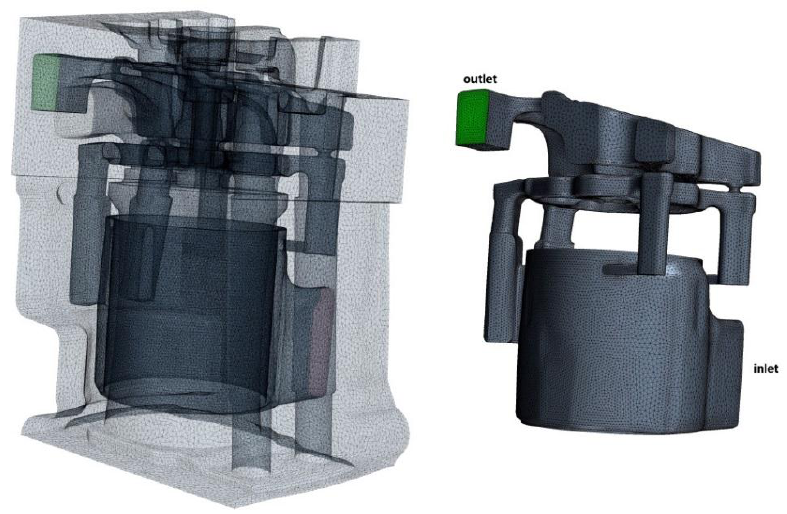
Figure 3. Mesh of the single cylinder engine model.